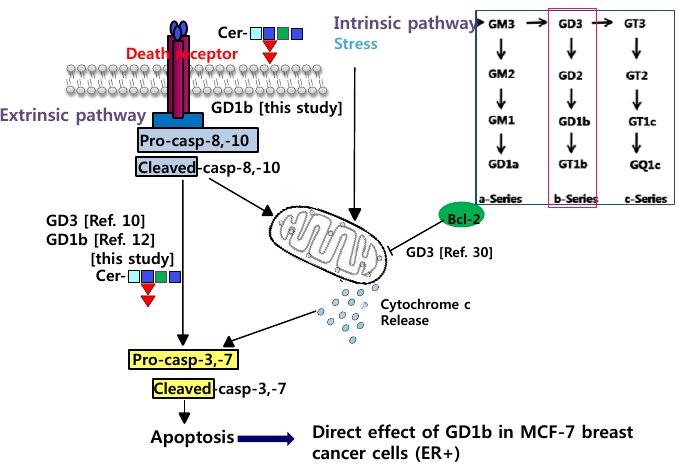
Figure 8. Schematic illustration of b-series gangliosides such as GD1b and GD3 for the apoptotic activities in breast cancer cells. The red square indicates b-series ganglioside during biosynthesis.